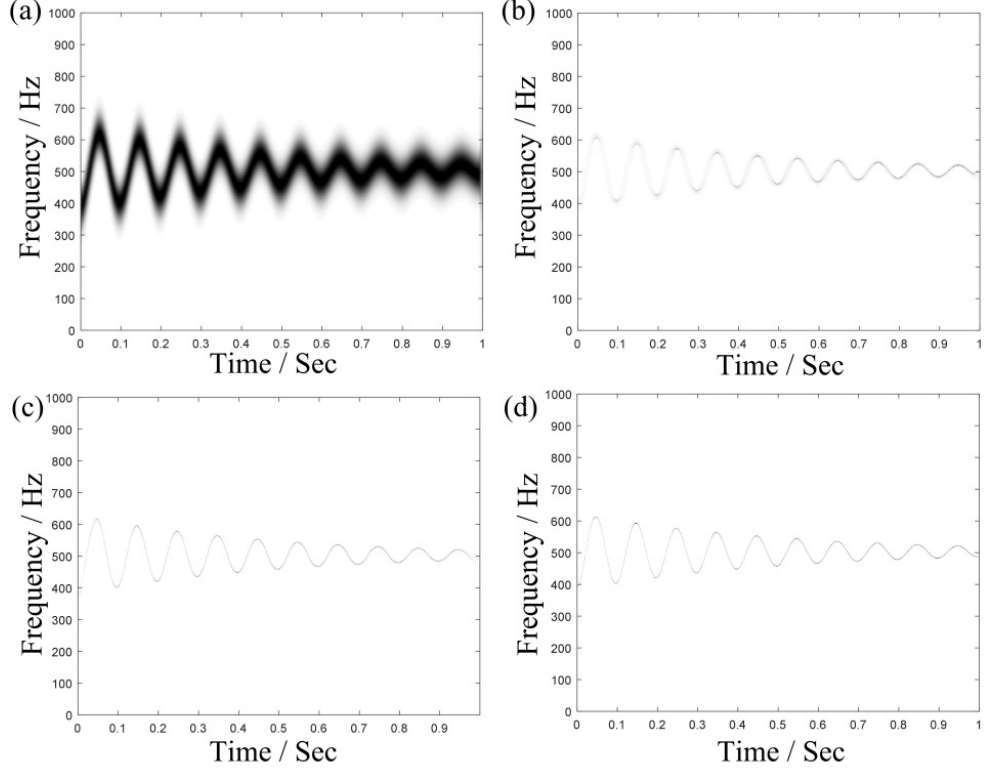
Sensors 2019 , 19 , x FOR PEER REVIEW Table 1.